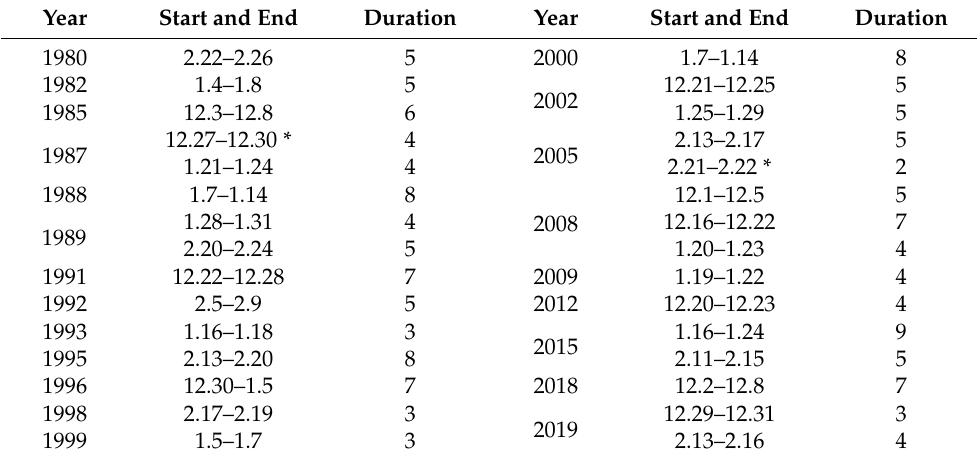
Table 1. Start and end dates and duration of 30 RSCEs (unit: d).